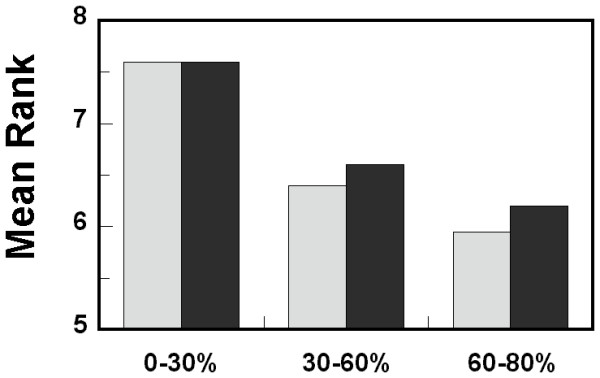
Comparison between EvDTree (grey) and FUGUE (black) at different levels of sequence identity in the test data set.